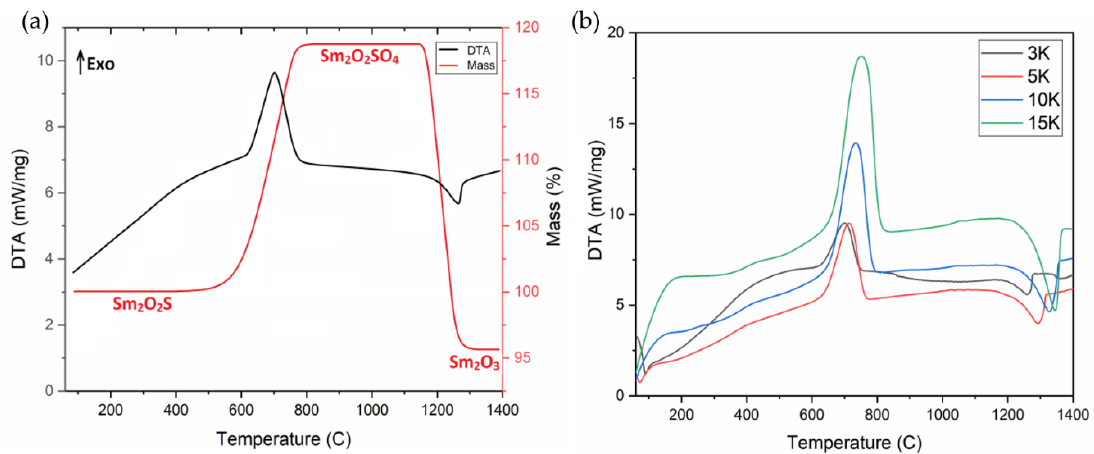
Figure 1. DTA / TGof Sm 2 O 2 S in synthetic air ( a ) and the shift of the peaks of thermal e ff ects depending Figure 1. DTA/TGof Sm 2 O 2 S in synthetic air ( a ) and the shift of the peaks of thermal effects on the heating rate ( b depending on the heating rate ( b ).